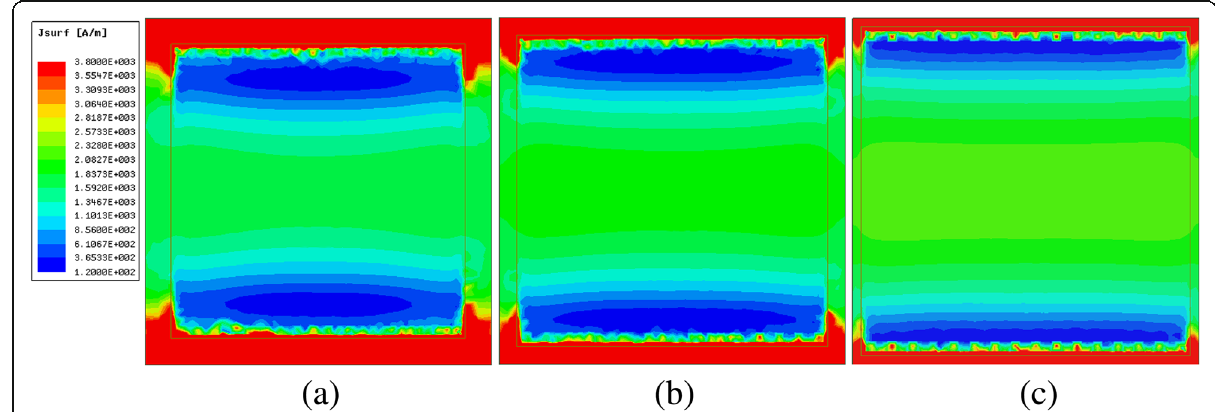
Fig. 8. Magnitude of surface current with different patch sizes but at the same frequency. a w = 17 μ m, b w = 18 μ m, and c w = 19 μ